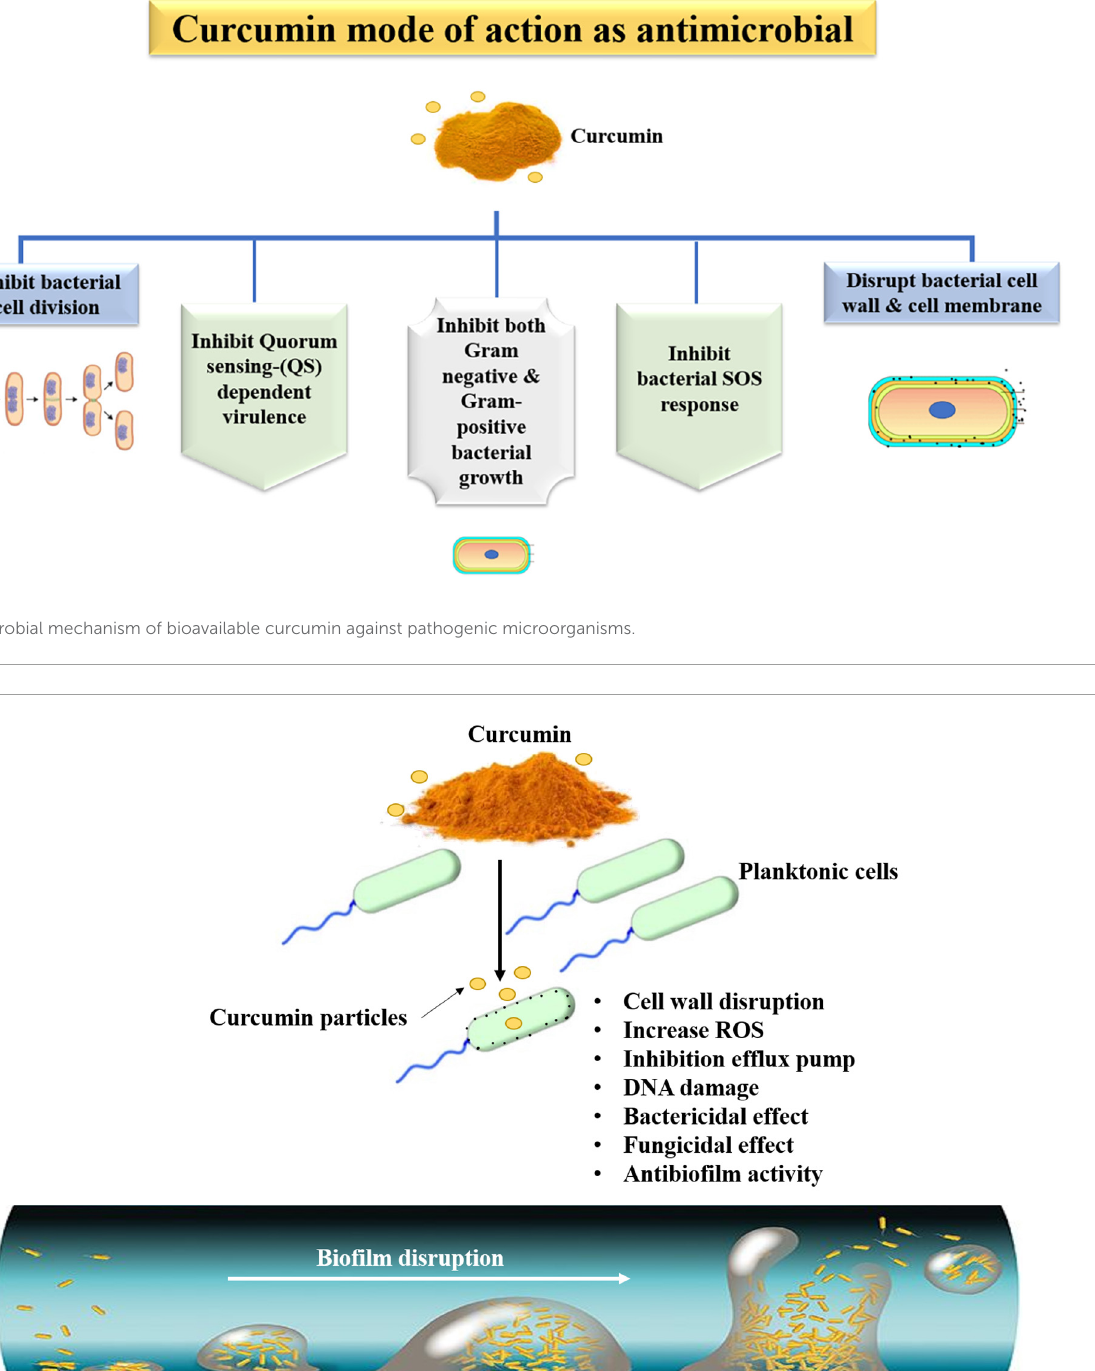
risk factor for tumor progression, such as tumor development and metastasis (164). In mammalians, the nuclear factor kappa B (NFkB) pathway, which plays a significant action